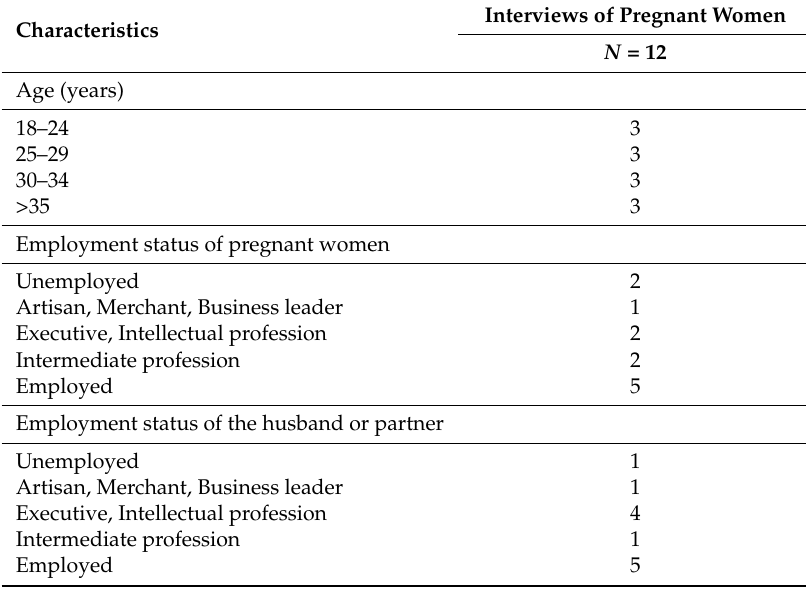
Table A1. Characteristics of semi-structured individual interviews